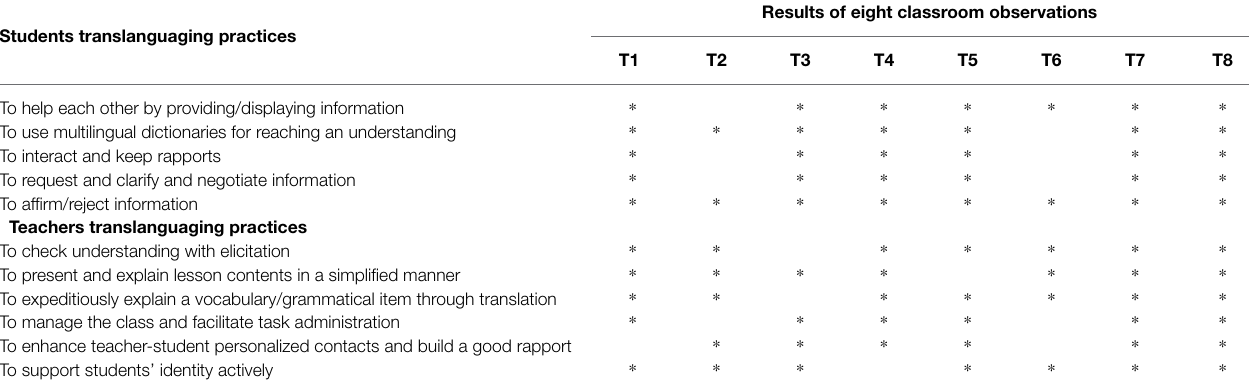
TABLE 3 | Translanguaging purposes across the eight observations.